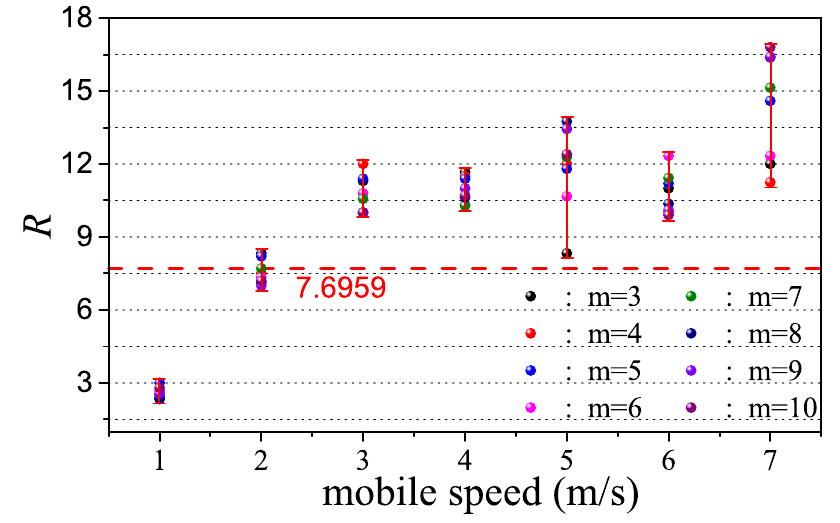
Figure 10. Relationship between R and mobile